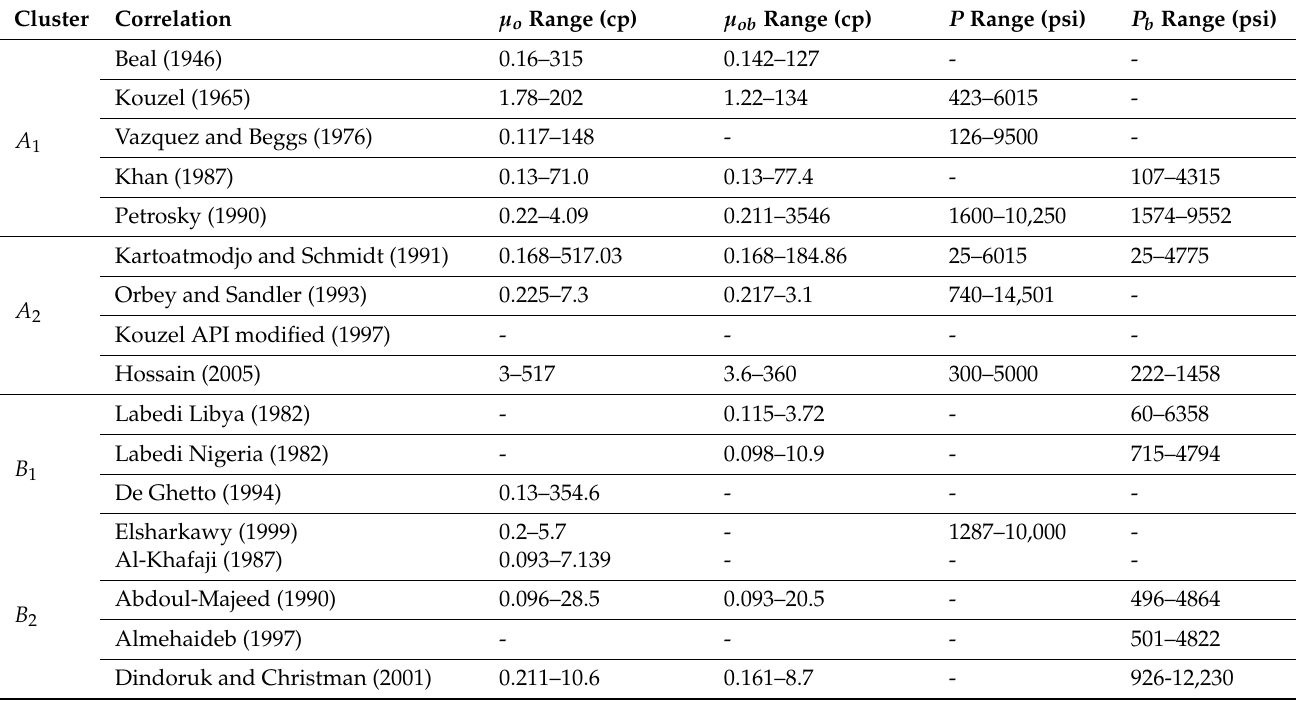
Table 5. Correlation input ranges of